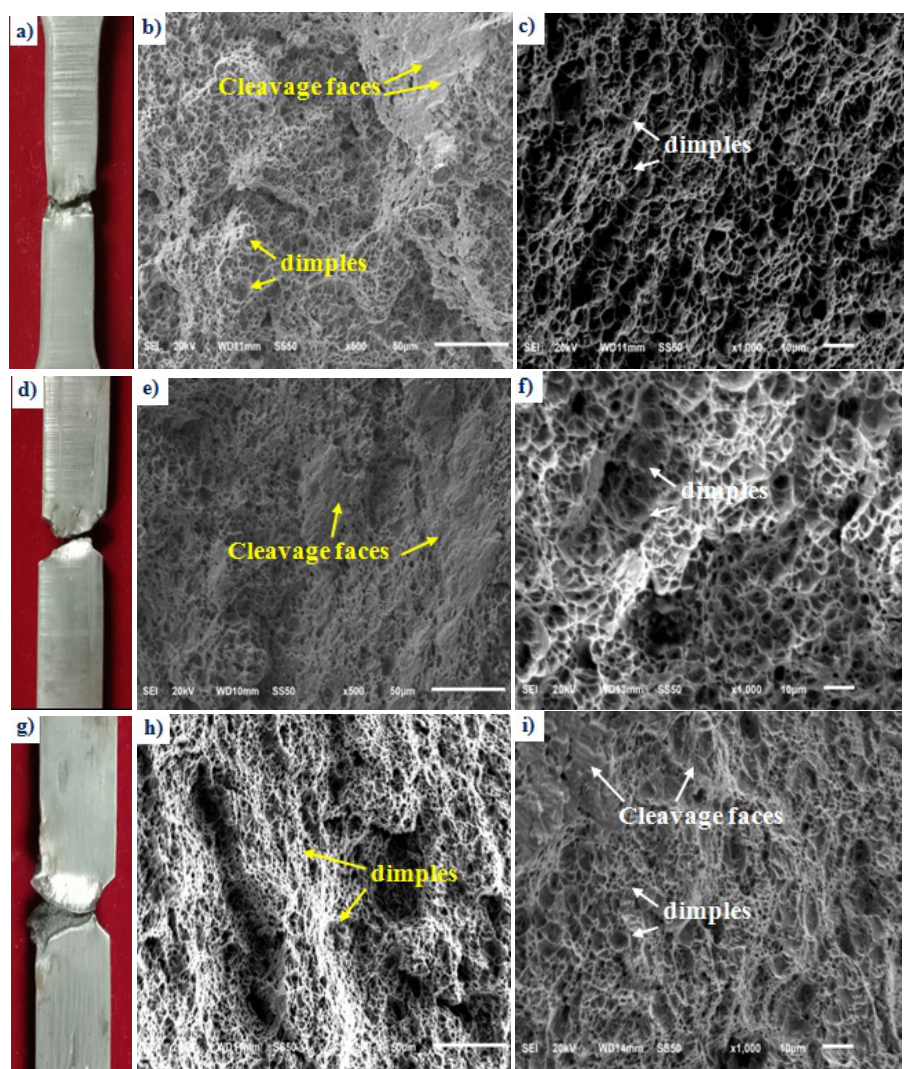
Figure 12: SEM fractographs of the specimen extracted from top region tested specimens, (a-c) smooth tensile, (d-f) notch tensile and (g-i) charpy